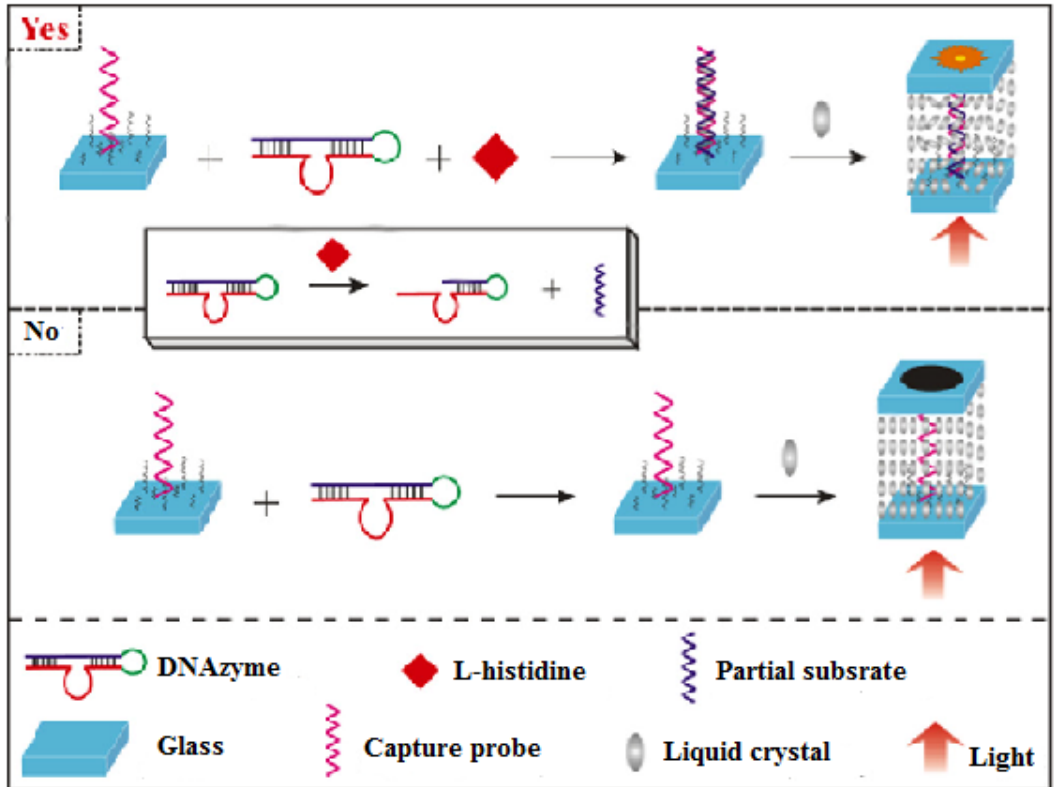
Figure 11. Description of the high-sensitivity DNAzyme-based LC biosensor for L-histidine. Only L-histidine can cleave the DNAzyme and release partial substrate, which hybridizes with the capture probe forming ds-DNA on the glass slide. The ds-DNA induces a homeotropic-to-tiled transition of the LCs, resulting in a birefringent texture of the optical image for LC cell [32]. Tan [33] proposed a new signal-enhanced LC biosensor based on target-triggering DNA dendrimers for the highly sensitive detection of p53 mutation gene fragments. The schematic of liquid crystal biosensing method based on DNA dendrimer signal enhancement is shown in Figure 12 In this study, hairpin DNA probes by a hybridization chain reaction. The shift of homologous to tilted alignment of